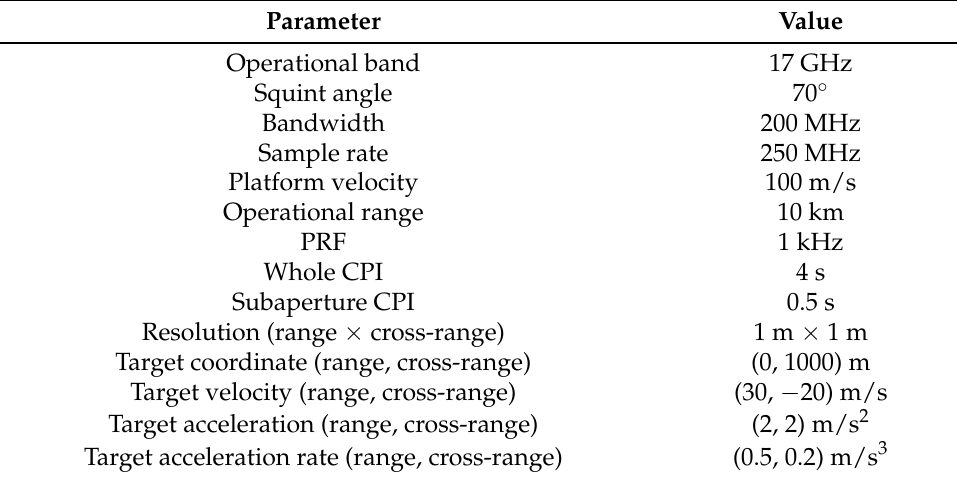
Table 2. Simulated